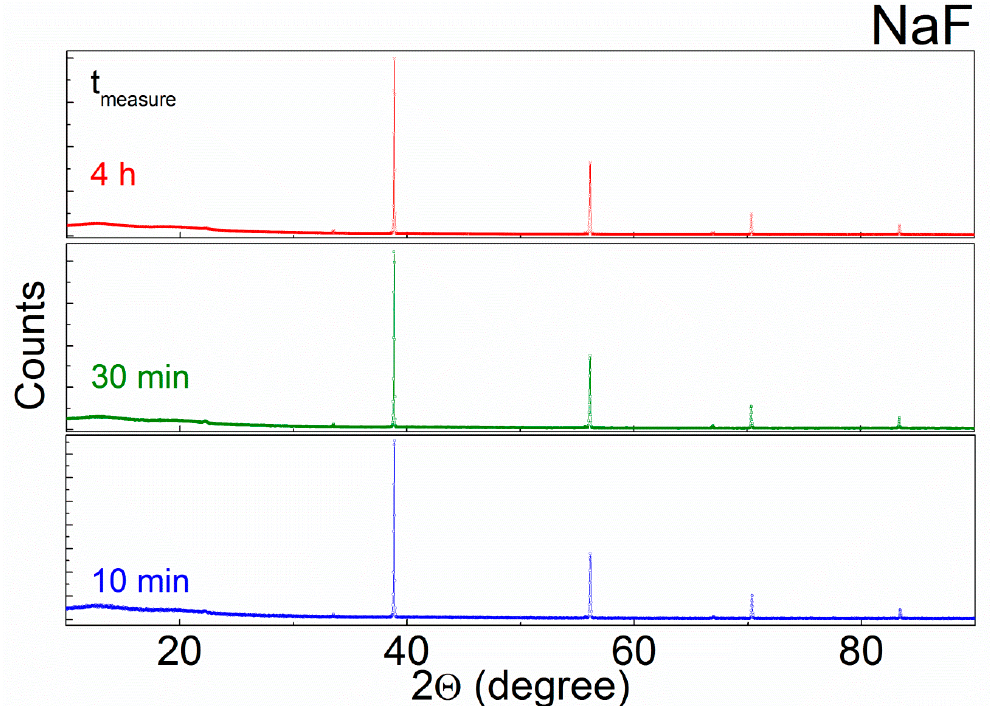
Figure 1. XRD pattern versus time of embedded NaF used in this study for synthesis of fuel mixtures. Plots show stability of the sample prepared under applied conditions at total times of 10 min, 30 min, and 4 h, respectively, as indicated within the figure.